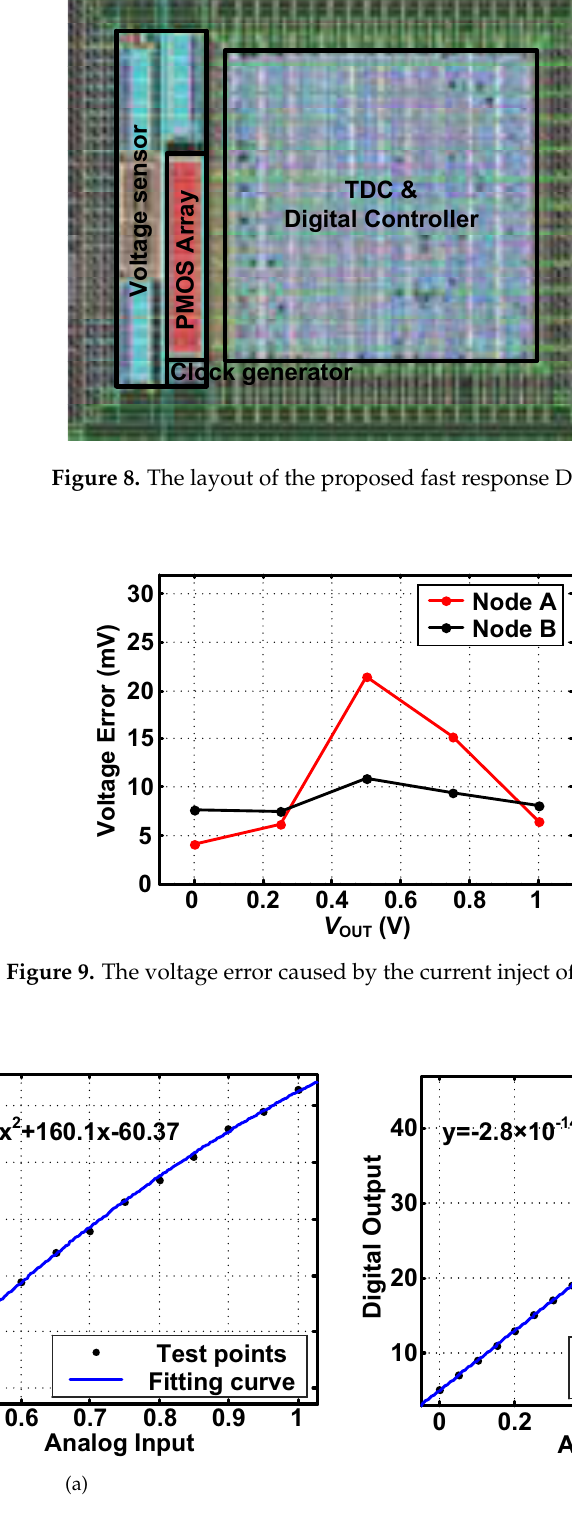
Figure 10. The comparison of linearity for: ( a ) conventional TDC; and ( b ) proposed